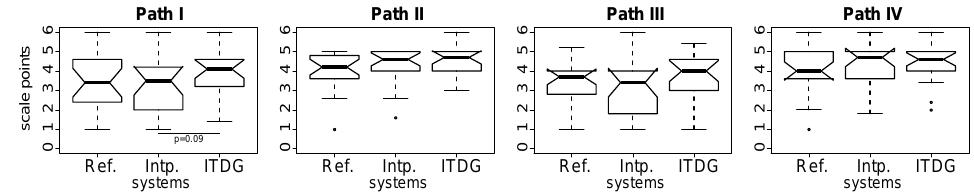
Figure 16. Box-plots for Localization Stability (LS) rated on the scale shown in Figure 12; Differences between distributions with p < 0.2 using a Wilcox-test are indicated; scale labels: 1 = instable, 5 = stable (data from the work in